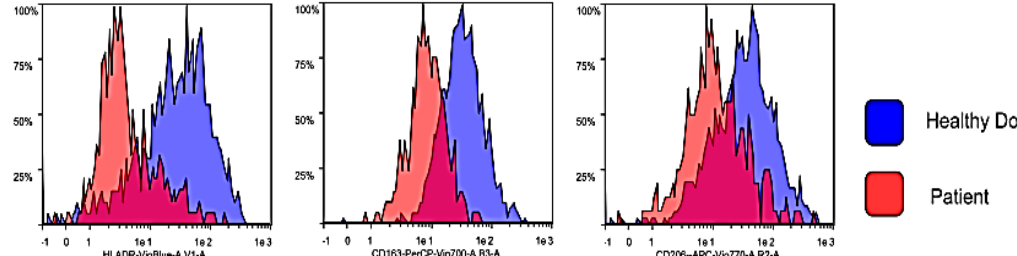
Figure 7. Expression of M2 markers in healthy donors and PD patients. Representative data obtained from one healthy donor-derived macrophage culture (blue histograms) and one patient-derived macrophage culture (red histogram). For the M2 markers a similar trend was observed: the healthy control subjects show a major expression of CD163 ( p = 0.009405). For the CD206 there was a major expression, but not statistically significant ( p = 0.063356).